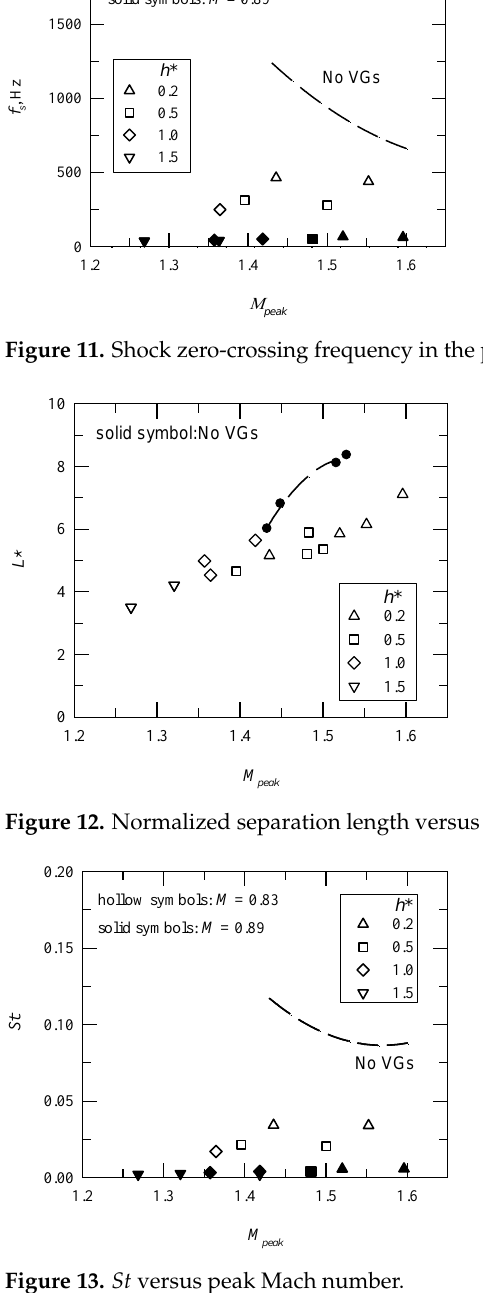
Figure 13. St versus peak Mach number.